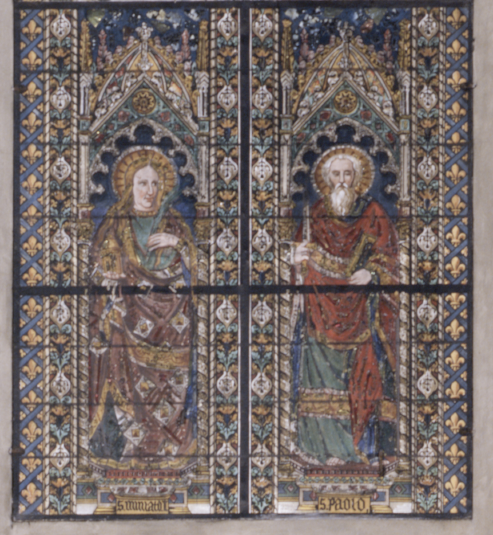
Figure 1. Image of a part of a two-lancet stained window in the Florence Cathedral, representing San Miniato (St Minias) on the left and San Paolo (St Paul) on the right. The artwork was made in 1395 by Antonio da Pisa and is recorded in the Italian Stained Glass Windows Database (BIVI). Reproduced with permission of Opera di Santa Maria del Fiore,